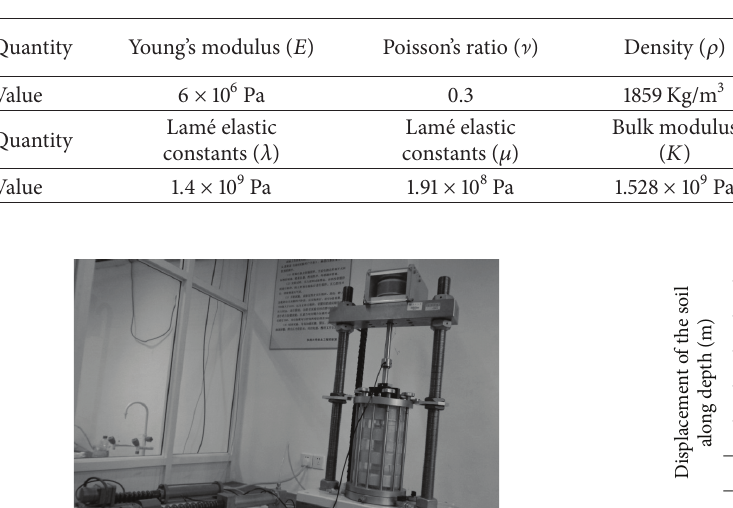
Table 4: The parameters of the soil.